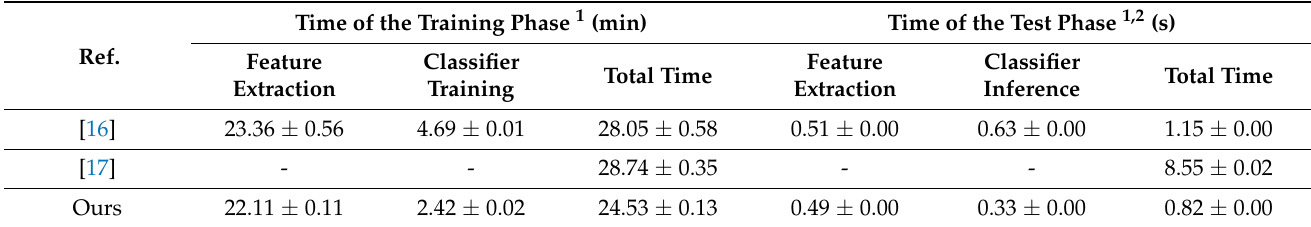
Table 9. The running time comparison for different methods on the MITDB.